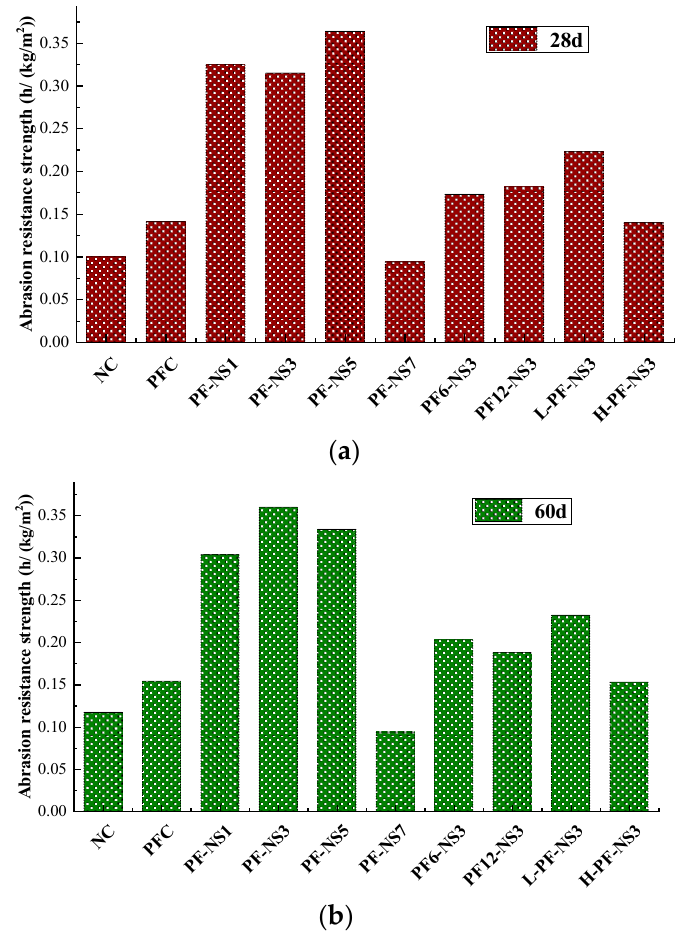
Figure 3. Change in concrete’s abrasion resistance strength at different proportions after curing for ( a ) 28 days and ( b ) 60 days. Table 4. Abrasion resistance strength of selected sample.